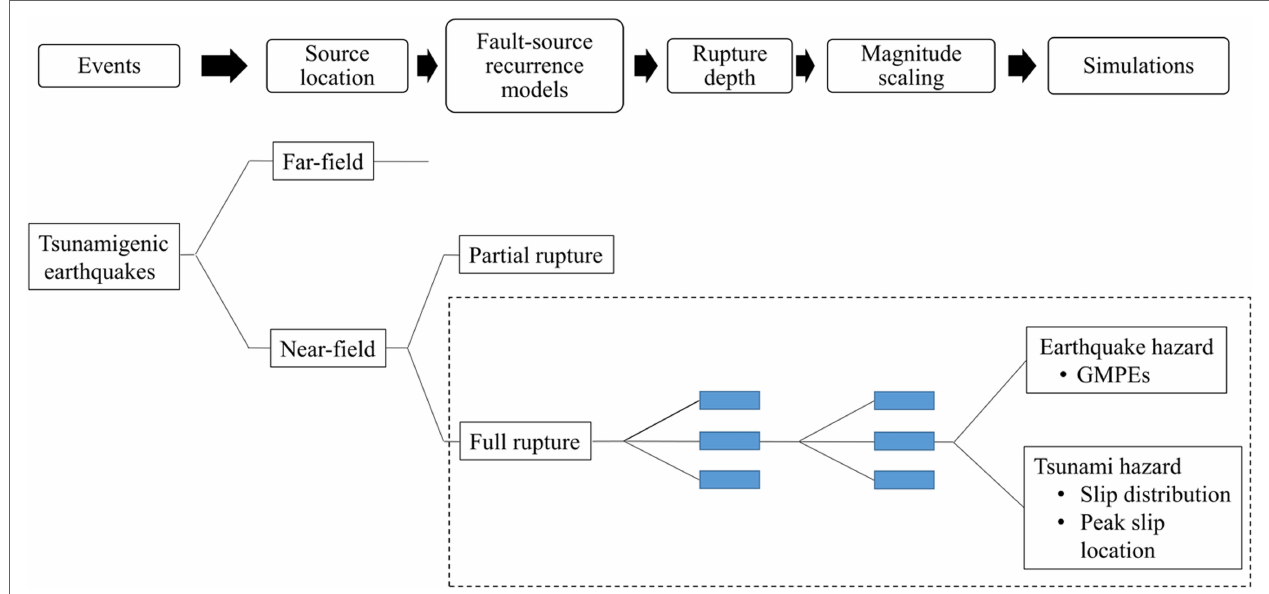
FIGURE 3 | Generic logic tree for the probabilistic seismic and tsunami hazard analysis. The dashed box shows the full-rupture event considered in the example applied to the Cascadia subduction